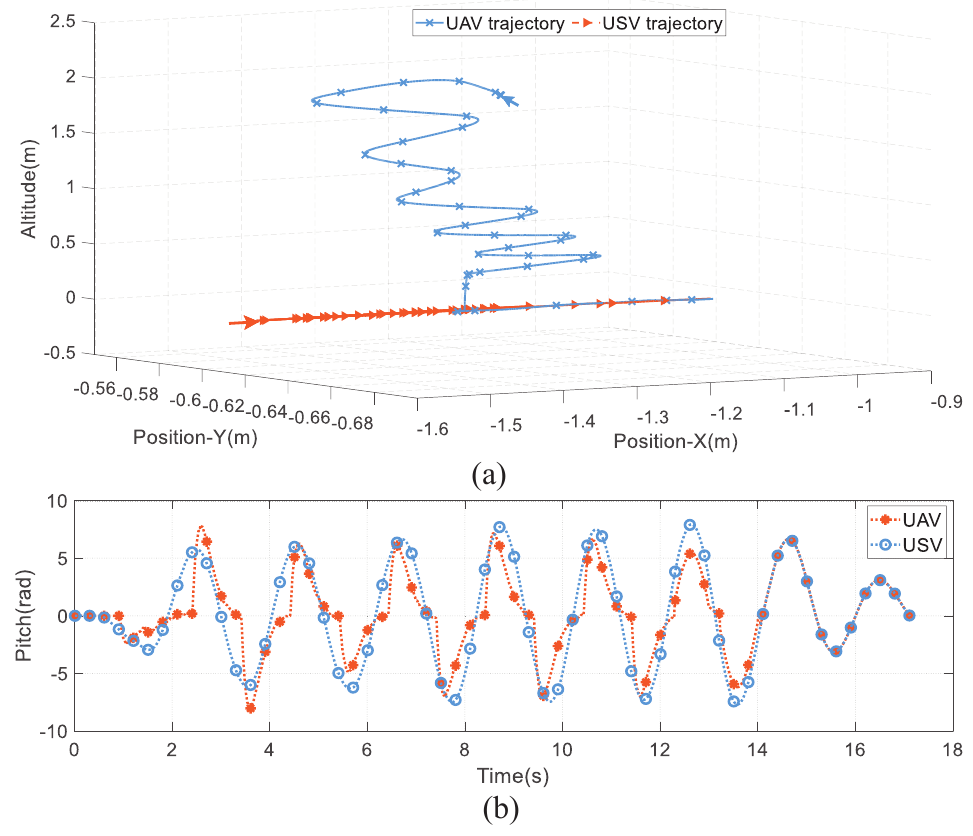
Figure 8. ( a ) USV pitching motion − UAV–USV three − dimensional trajectories; ( b ) the variation of UAV–USV pitch angle. (cid:28595)